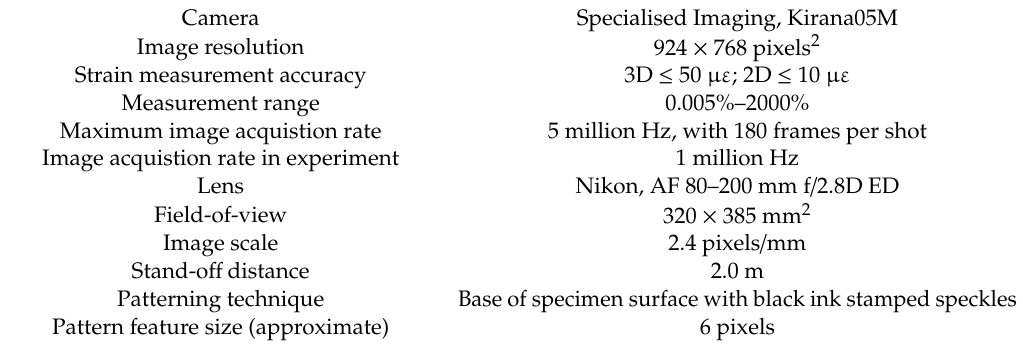
Table 2. DIC analysis